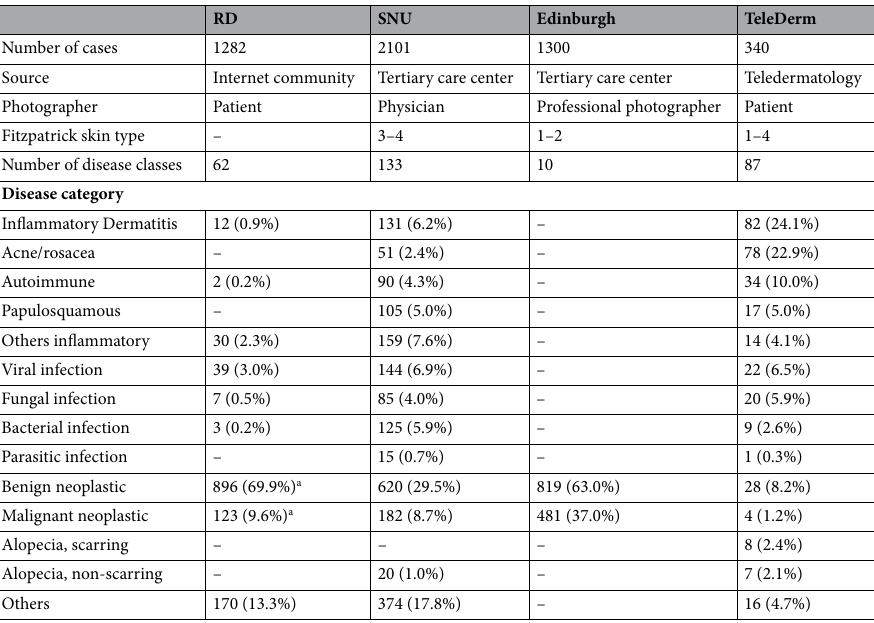
Table 1. Summary of the test datasets. a The ground truth of the RD dataset was voted on by five specialists, whereas the malignancies in the other datasets were determined by pathological